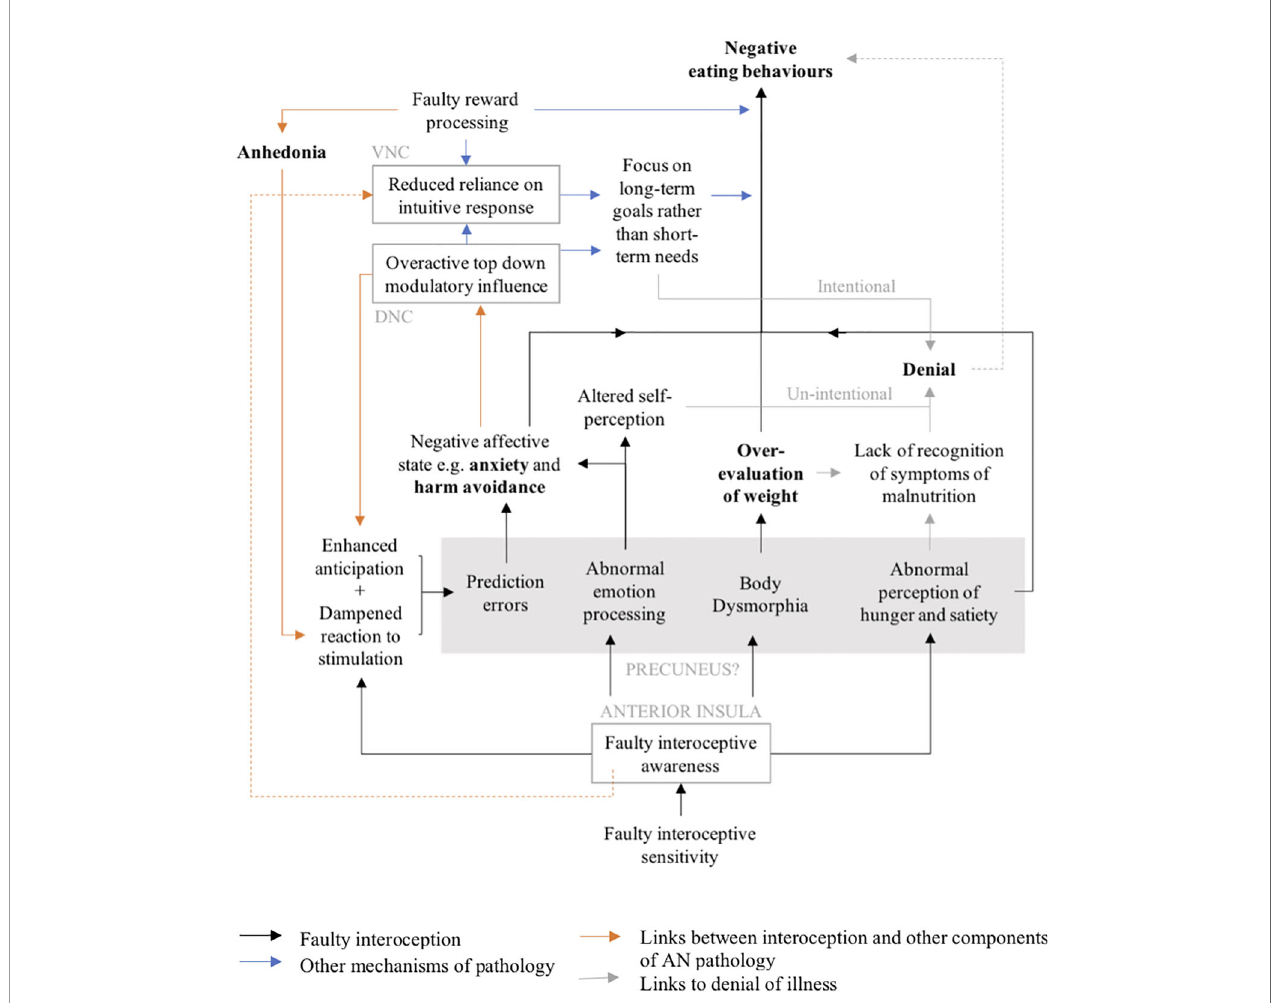
FIGURE 2 | Model for the neuro-circuitry of AN: VNC, ventral (limbic) neuro-circuit — primarily ventral striatum; DNC, dorsal (cognitive) neuro-circuit — primarily dorsolateral prefrontal